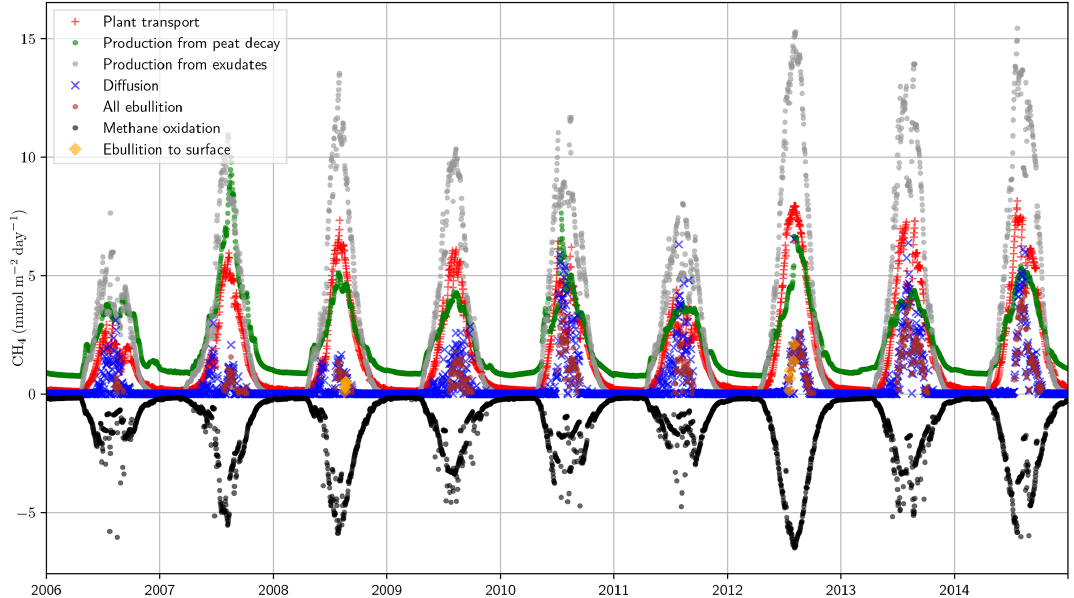
Figure 12. Diffusion, plant transport, ebullition, CH 4 production, and CH 4 oxidation time series for parameter values from the posterior mean estimate. The figure shows how only a minor part of ebullition in the end comes to the surface as ebullition. The total flux and the observations are shown in Fig. 9.